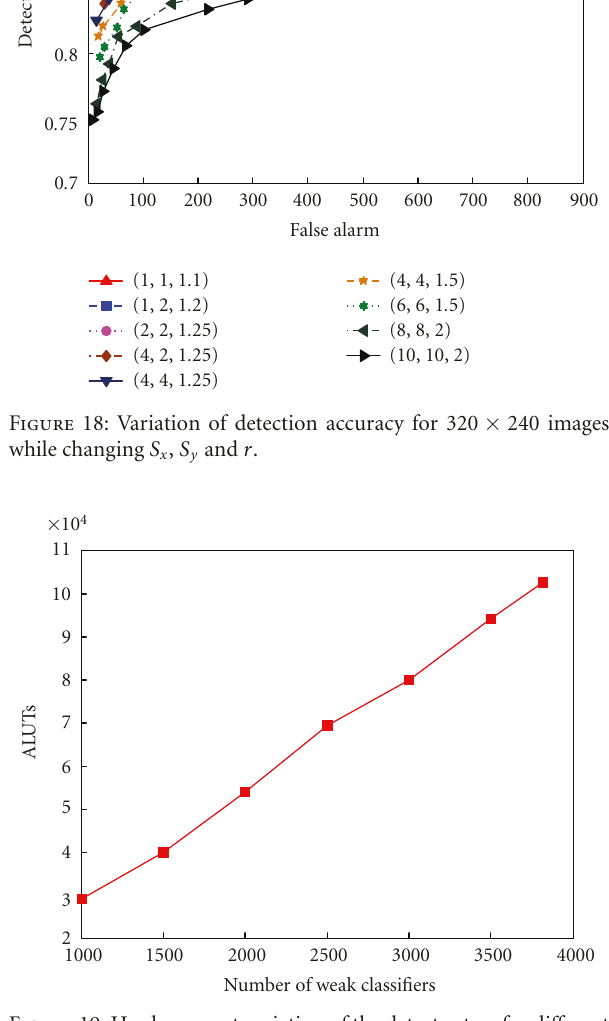
Figure 19: Hardware cost variation of the detector tree for di ff erent number of weak